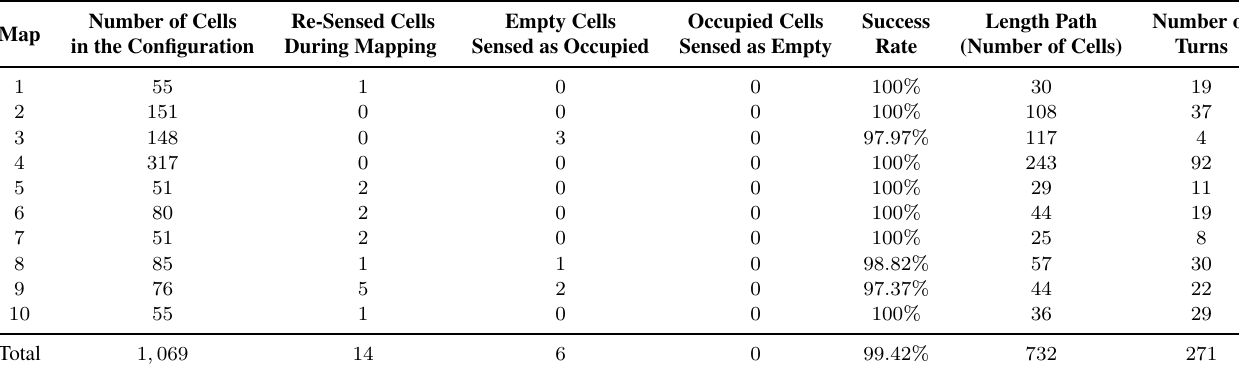
Table 1. Experimental mapping